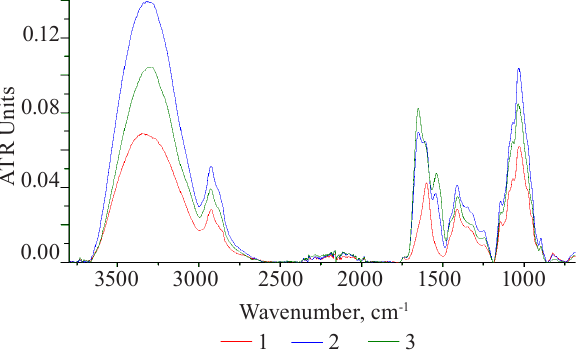
Figure 10 IR-spectra of the PS-complex samples that resulted from sequential extraction of flax seeds: (1) PSC-1 (2.4% of protein), (2) PSC-2 (10.2% of protein), (3) (PSC-3 (25.4% of